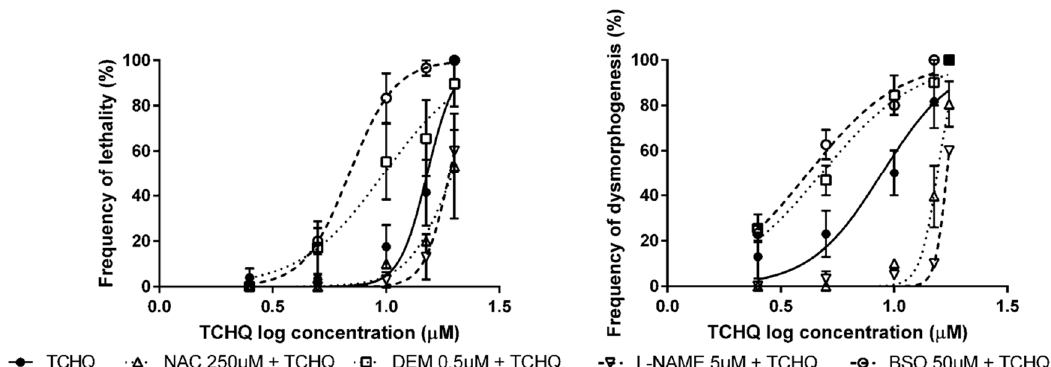
Figure 2. Concentration–response curves for lethality and dysmorphogenesis of tetrachlorohydroquinone (TCHQ) alone or in combination with modulators of antioxidant